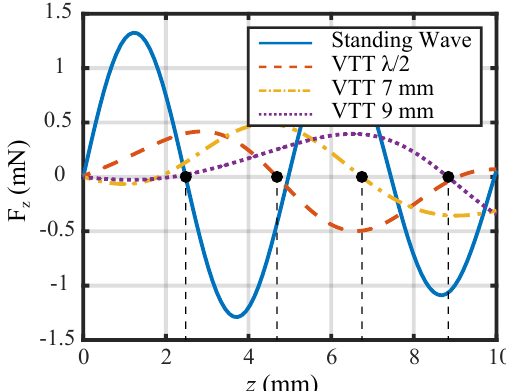
Figure 7. Vertical forces for a standing wave with a minimum at z = λ /4 and VTTs at z = λ /2, z = 7mm, and z = 9mm. The forces are obtained for an acoustically reflective surface ( R = 1) at z =